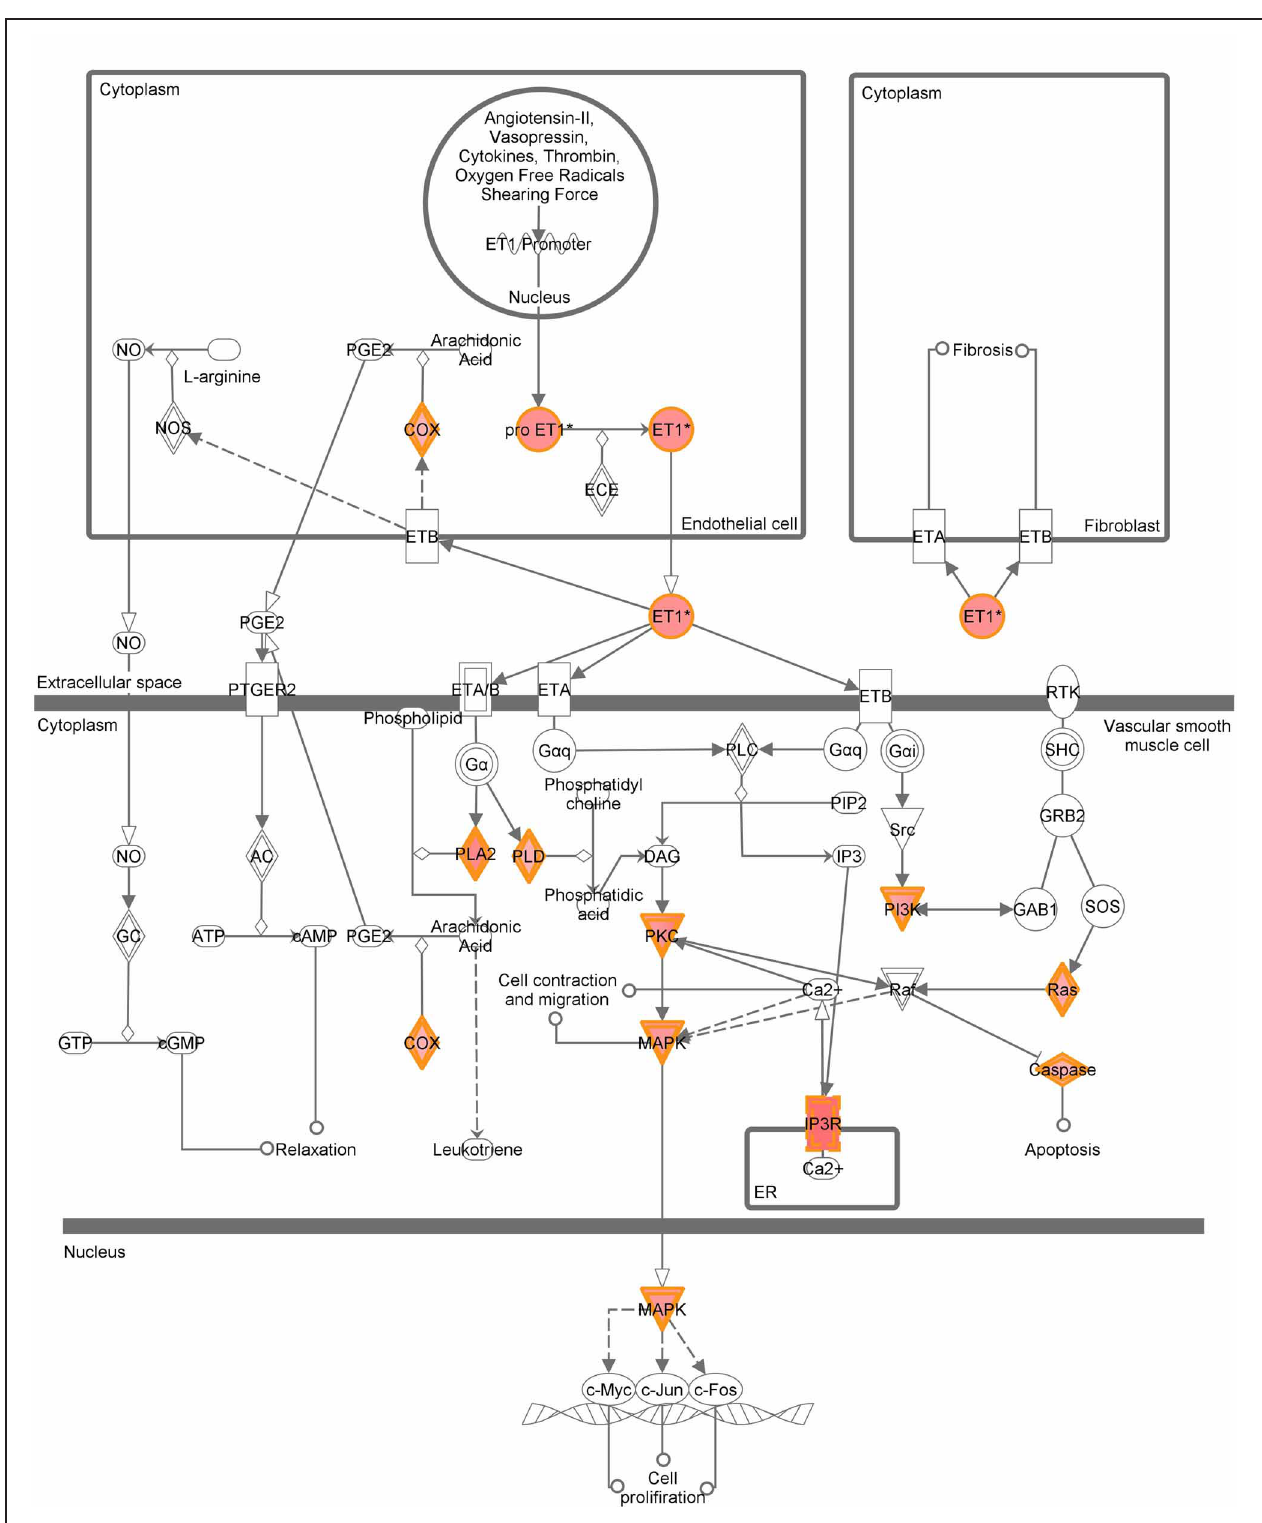
FIGURE A7 | Endothelin-1